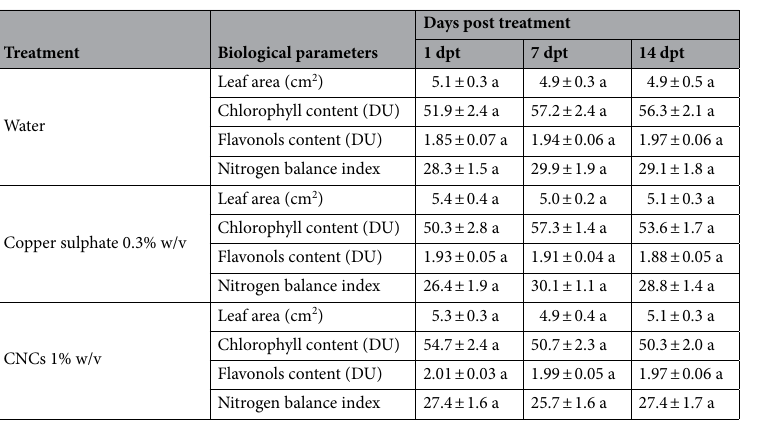
Table 2. Biological parameters of olive tree seedling treated with a CNCs suspension at 1% w/v, water and copper sulphate at 0.3% w/v measured at 1, 7 and 14 days after treatments. No statistical differences were recorded. “± value” refers to standard deviation between 20 measurements collected on ten plants per thesis. In vivo experiments were conducted thrice, and the effect of the experiment was not significant. Leaf area is expressed as square centimetres (cm 2 ) while chlorophyll and flavonols contents are reported as Dualex Unities